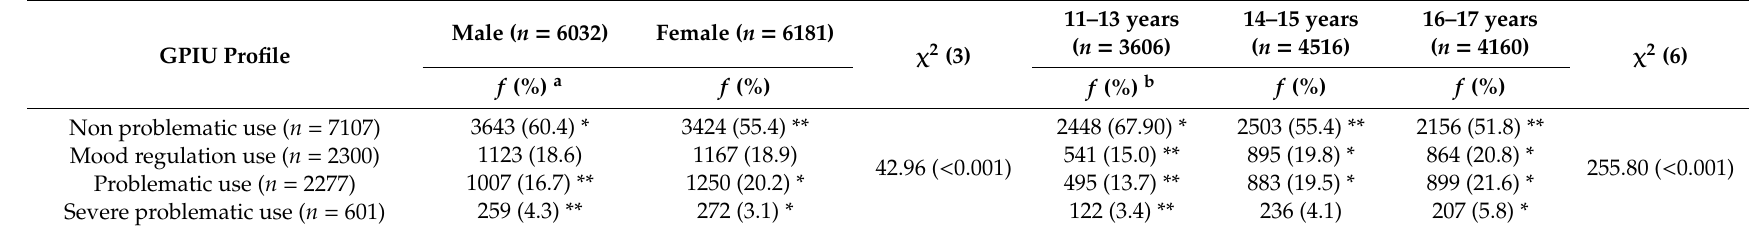
Table 4. Sex and age distribution in the GPIU profiles.